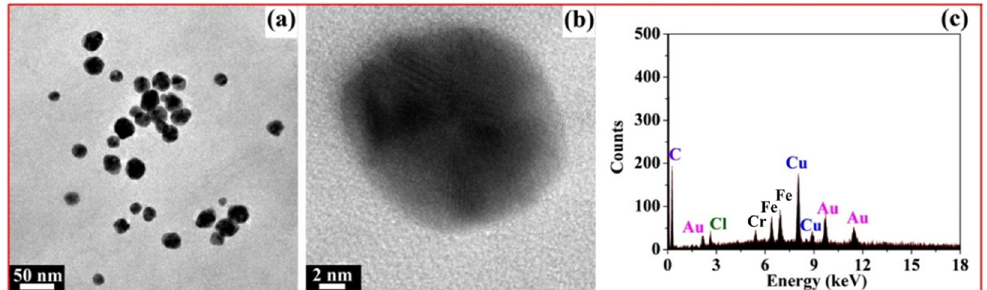
Figure 9. ( a ) TEM image of fresh AuNPs; ( b ) high-resolution transmission electron microscopy (HRTEM) image of single AuNP; ( c ) corresponding EDS profile of Xylan-click-QCS/AuNP composite.